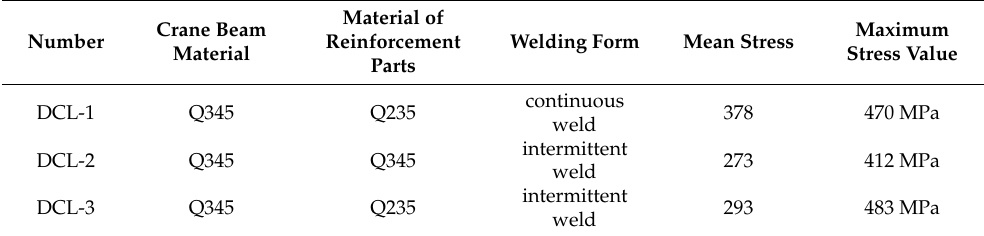
Table 7. Residual stress analysis results of the crane beam